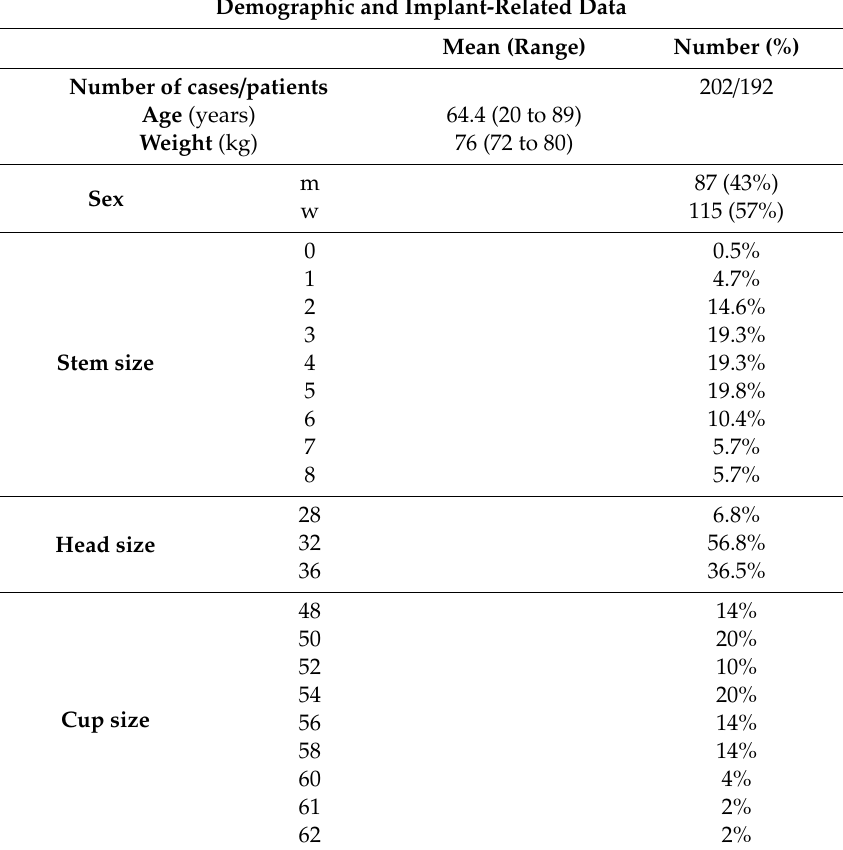
Table 1. Demographic and implant-related data